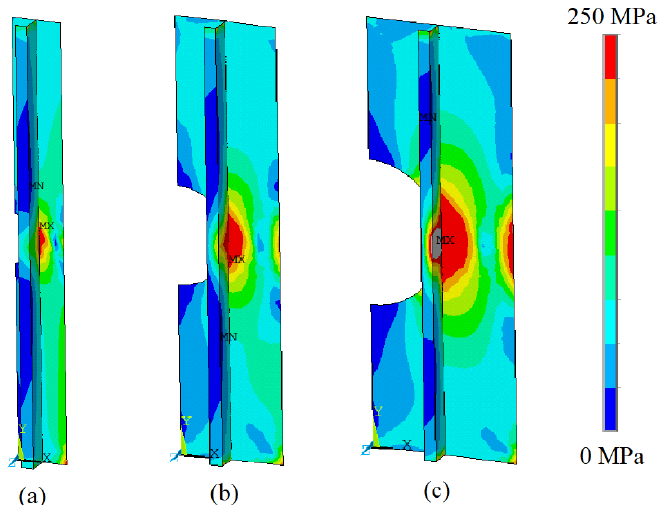
Figure 10. The von Mises stress distribution for the stiffened plate with semi-circular opening and width of ( a ) 170 mm, ( b ) 340 mm, and ( c ) 510 mm. width of ( a ) 170 mm, ( b ) 340 mm, and ( c ) 510 mm.